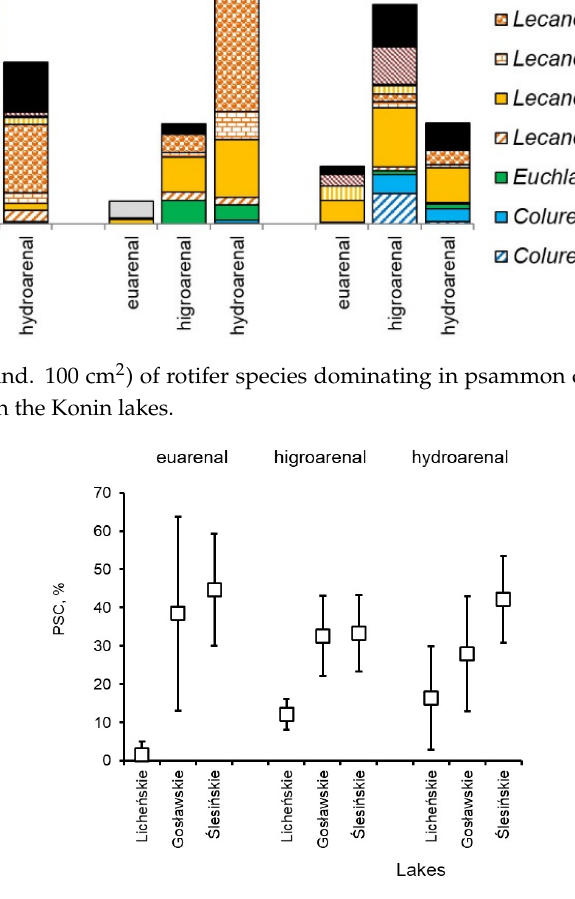
Figure 10. Numbers of rotifer species in the three habitats of Konin lakes compared to different lakes in northeastern Poland and their relation to the number of analyzed samples; p -value in all cases < 0.0001. Black circles show number of species found in the studied Konin Lakes; open circles and regression lines - data for the remaining lakes. Explanations: 1 - Lake Gos ł awskie; 2 - Lake Liche ń skie; 3 - Lake Ś lesi ń skie.